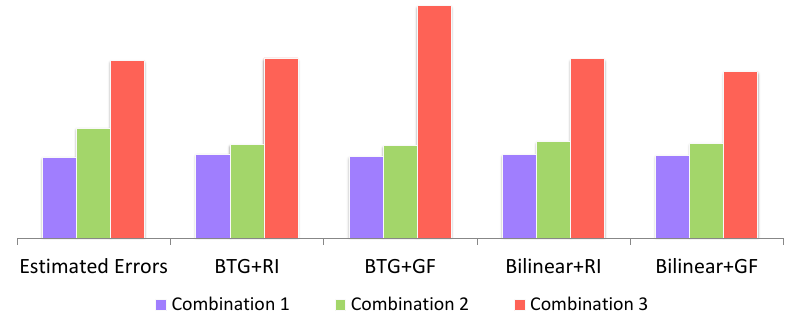
Figure 10. Comparison between estimated errors and actual reconstruction errors using different demosaicing methods (BTG + RI, BTG + GF, Bilinear + RI, Bilinear + GF) with the channels and patterns shown in Figure 9. The estimated errors are scaled for comparison.